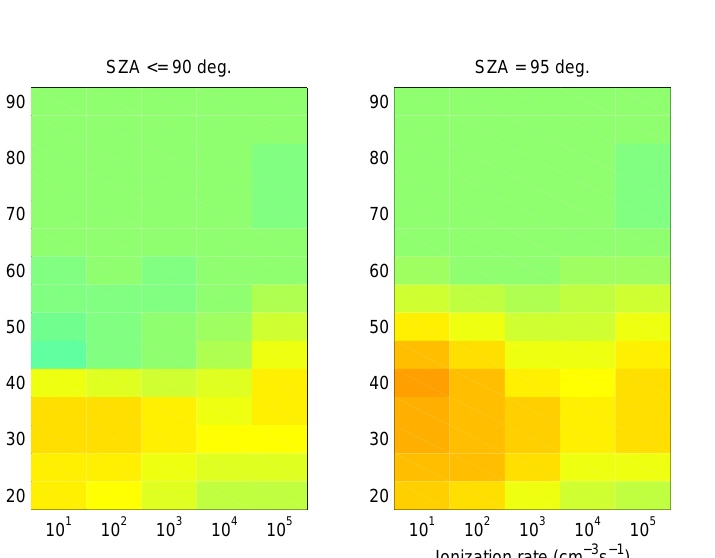
/Q for January 3